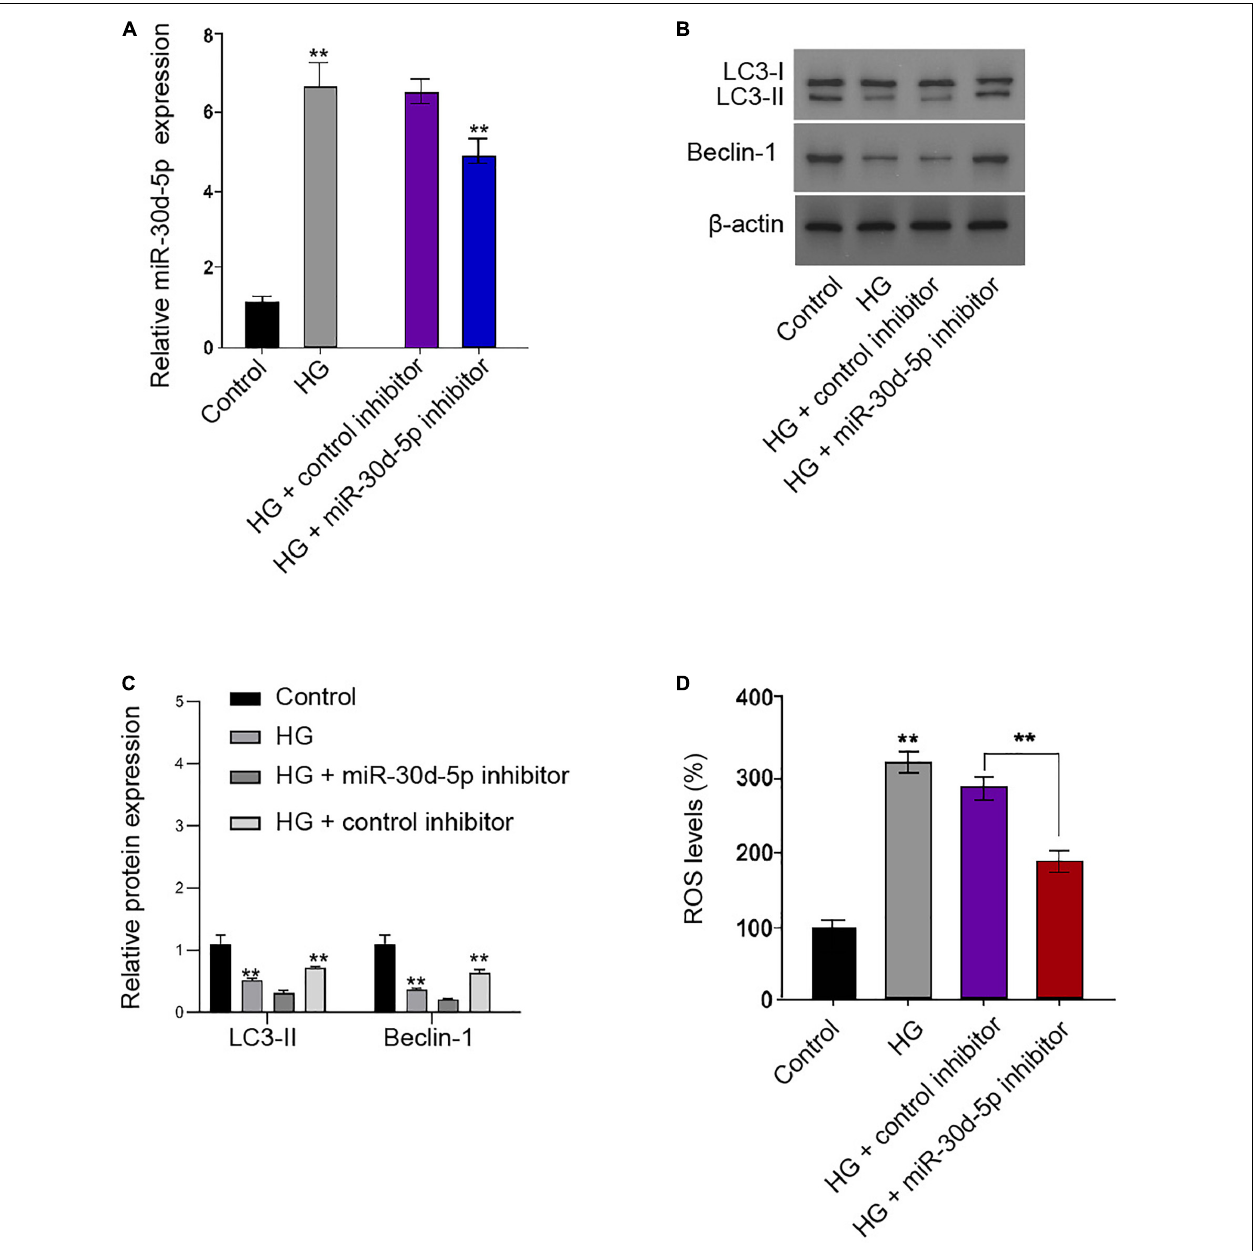
FIGURE 5 | MiR-30d-5p inhibits autophagy and promotes oxidative stress in the HG-treated Schwann cells. (A–D) The RSC96 cells are treated with HG, or co-treated with HG and miR-30d-5p inhibitor. (A) The expression of miR-30d-5p is detected by qPCR assays. (B,C) The expression of LC3I, LC3II, and Beclin-1 is assessed by Western blot analysis. (D) DCFH–DA staining shows the ROS production. N = 3, mean ± SD, * P < 0.05, ** P <